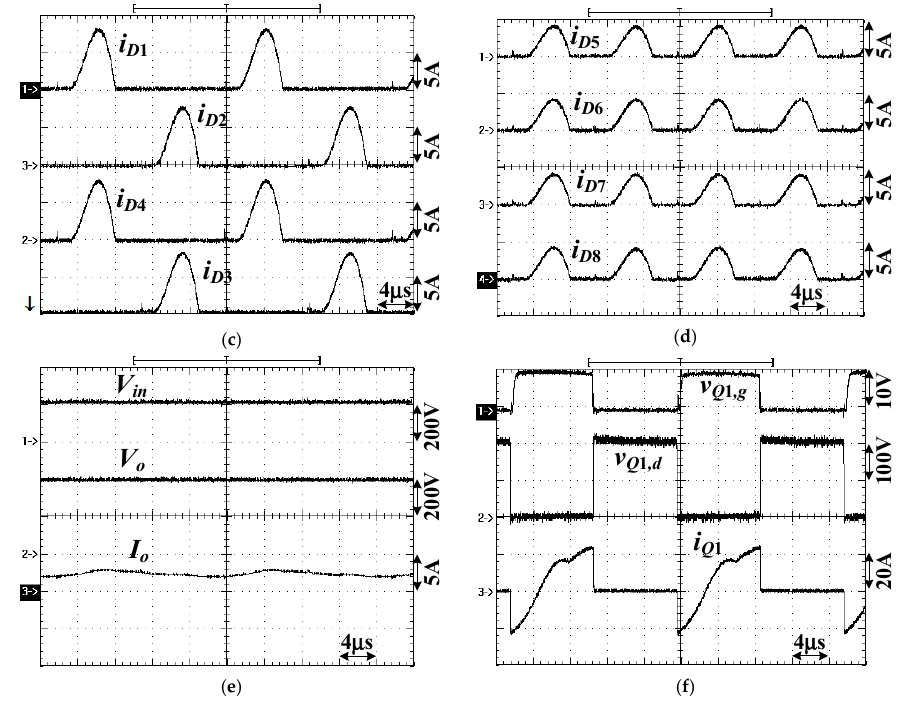
Figure 10. Experimental waveforms at V in = 210 V (high voltage range) and 1 kW load. (a) v Q 1, g ~ v Q 4, g, (b) v ab , v Cr 1 , i Lr 1, (c) i D 1 ~ i D 4, (d) i D 5 ~ i D 8, (e) V in , V o , I o, (f) v Q 1 ,g , v Q 1 ,d , i Q 1 .